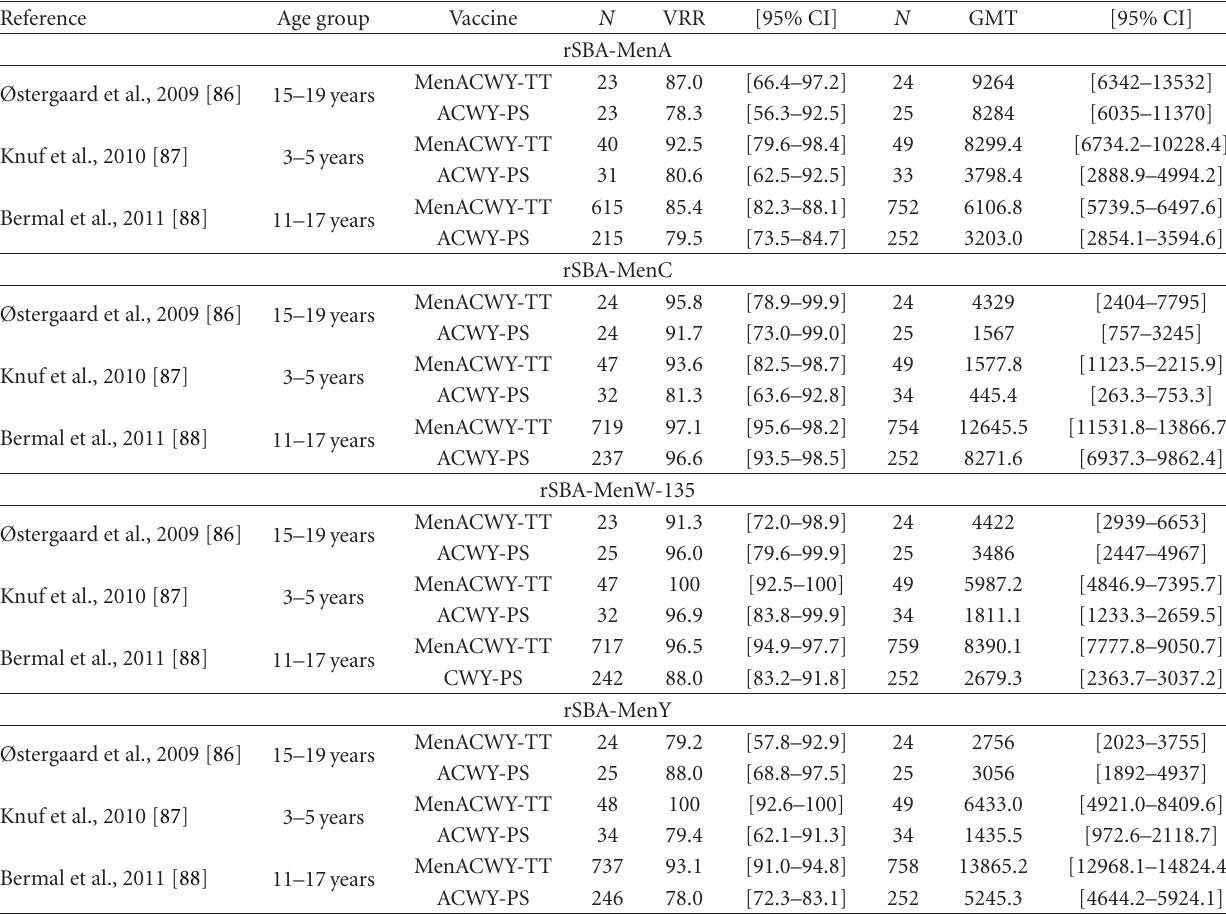
Table 6: rSBA-MenA, rSBA-MenC, rSBA-MenW-135, and rSBA-MenY antibody response one month after MenACWY-TT vaccination in children and adolescents (ATP immunogenicity cohort).